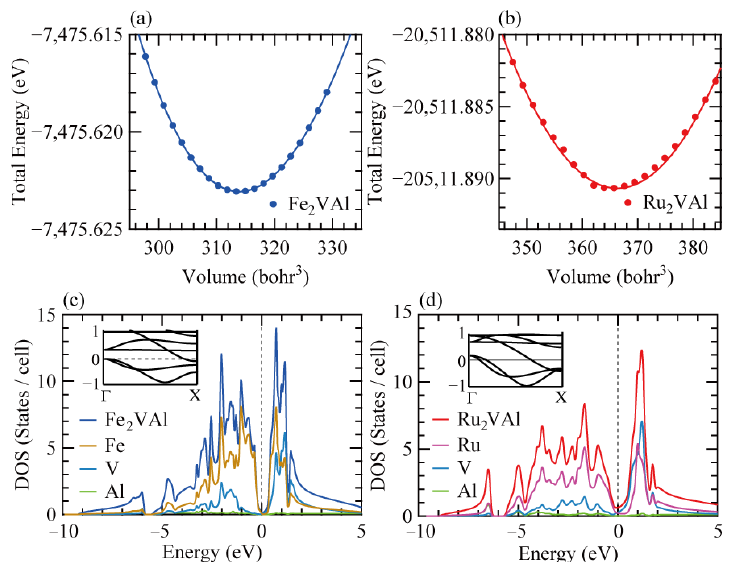
Figure 1. Volume dependence of the total energy of Fe 2 VAl ( a ) and Ru 2 VAl ( b ). The curves are the result of fitting with the Birch–Murnaghan equation of state. Calculated density of states of Fe 2 VAl ( c ) and Ru 2 VAl ( d ). The inset shows the band structure along the Г –X line. Table 1. Lattice parameter and Young’s modulus of Fe 2 VAl and Ru 2 VAl.